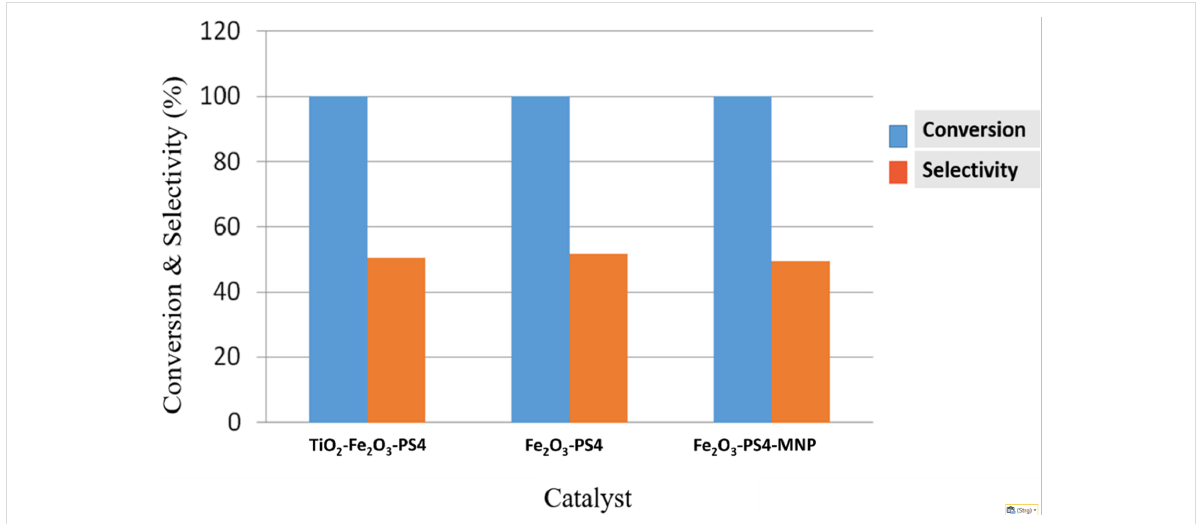
Figure 7: Conversion and selectivity of the alkylation of toluene with conventional heating for the three catalytic systems.